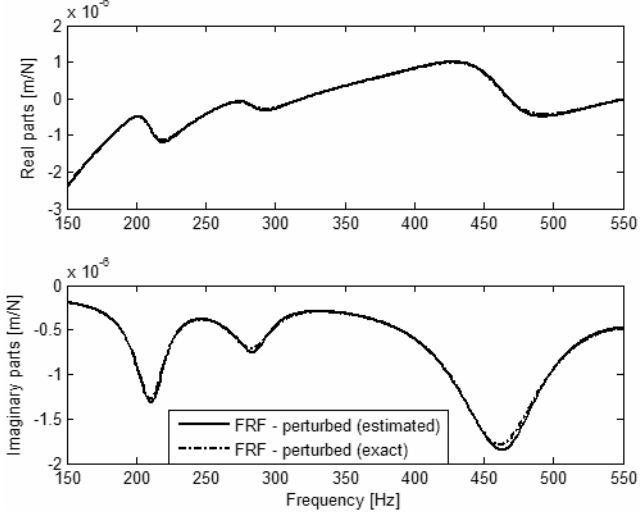
Fig. 10. Exact and first-order estimation of the FRF H II ( ω,T,p ) of the perturbed system by variations of the constraining layer